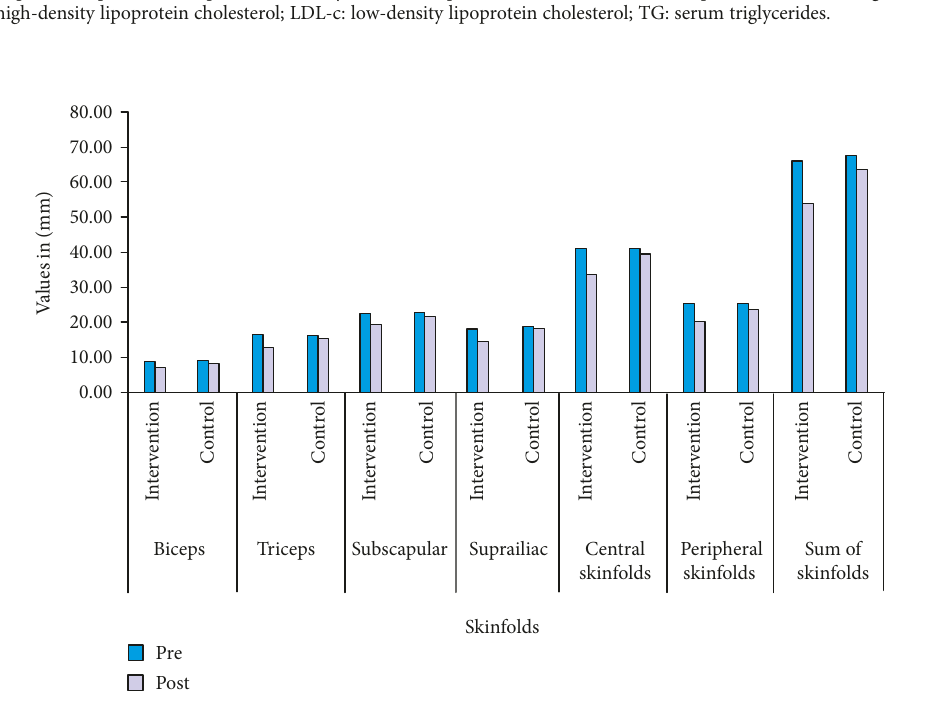
Figure 2: Changes in absolute values of skinfold thickness and sum of skinfolds after intervention. All the values are signi fi cant < 0.05. Values placed above bars are absolute values of respective skinfolds in mm. See Table 5 for SD of skinfold measurements. ∗ Central skinfold is the sum of subscapular and suprailiac skinfolds, peripheral skinfold is the sum of biceps and triceps skinfolds, and the sum of skinfolds is the sum of all the 4 skinfolds ( ∑ 4SF, biceps, triceps, subscapular, and